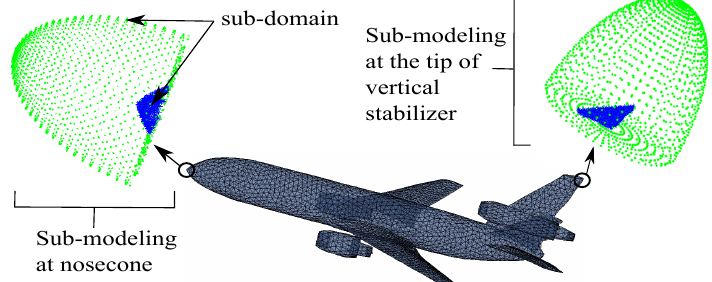
Figure 6. Schematic showing sub-modeling at two extremities of the aircraft. In the enlarged view of sub-models, the green colored regions are the surrounding ellipsoidal domains and the blue colored regions are parts of the aircraft.